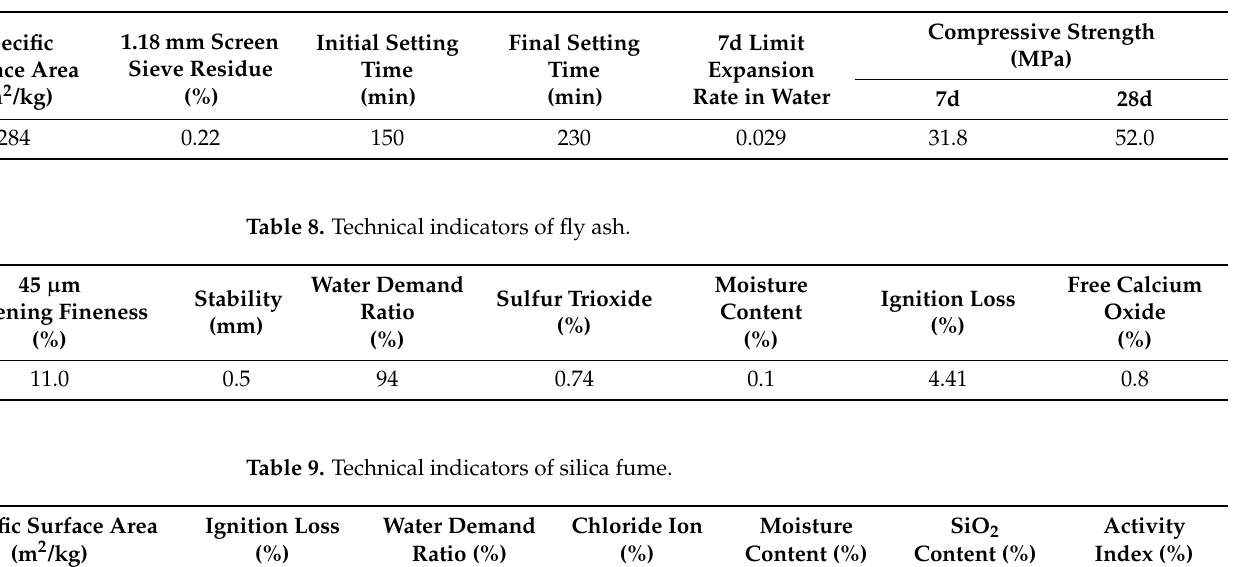
Table 7. Technical indicators of calcium sulfoaluminate cement.